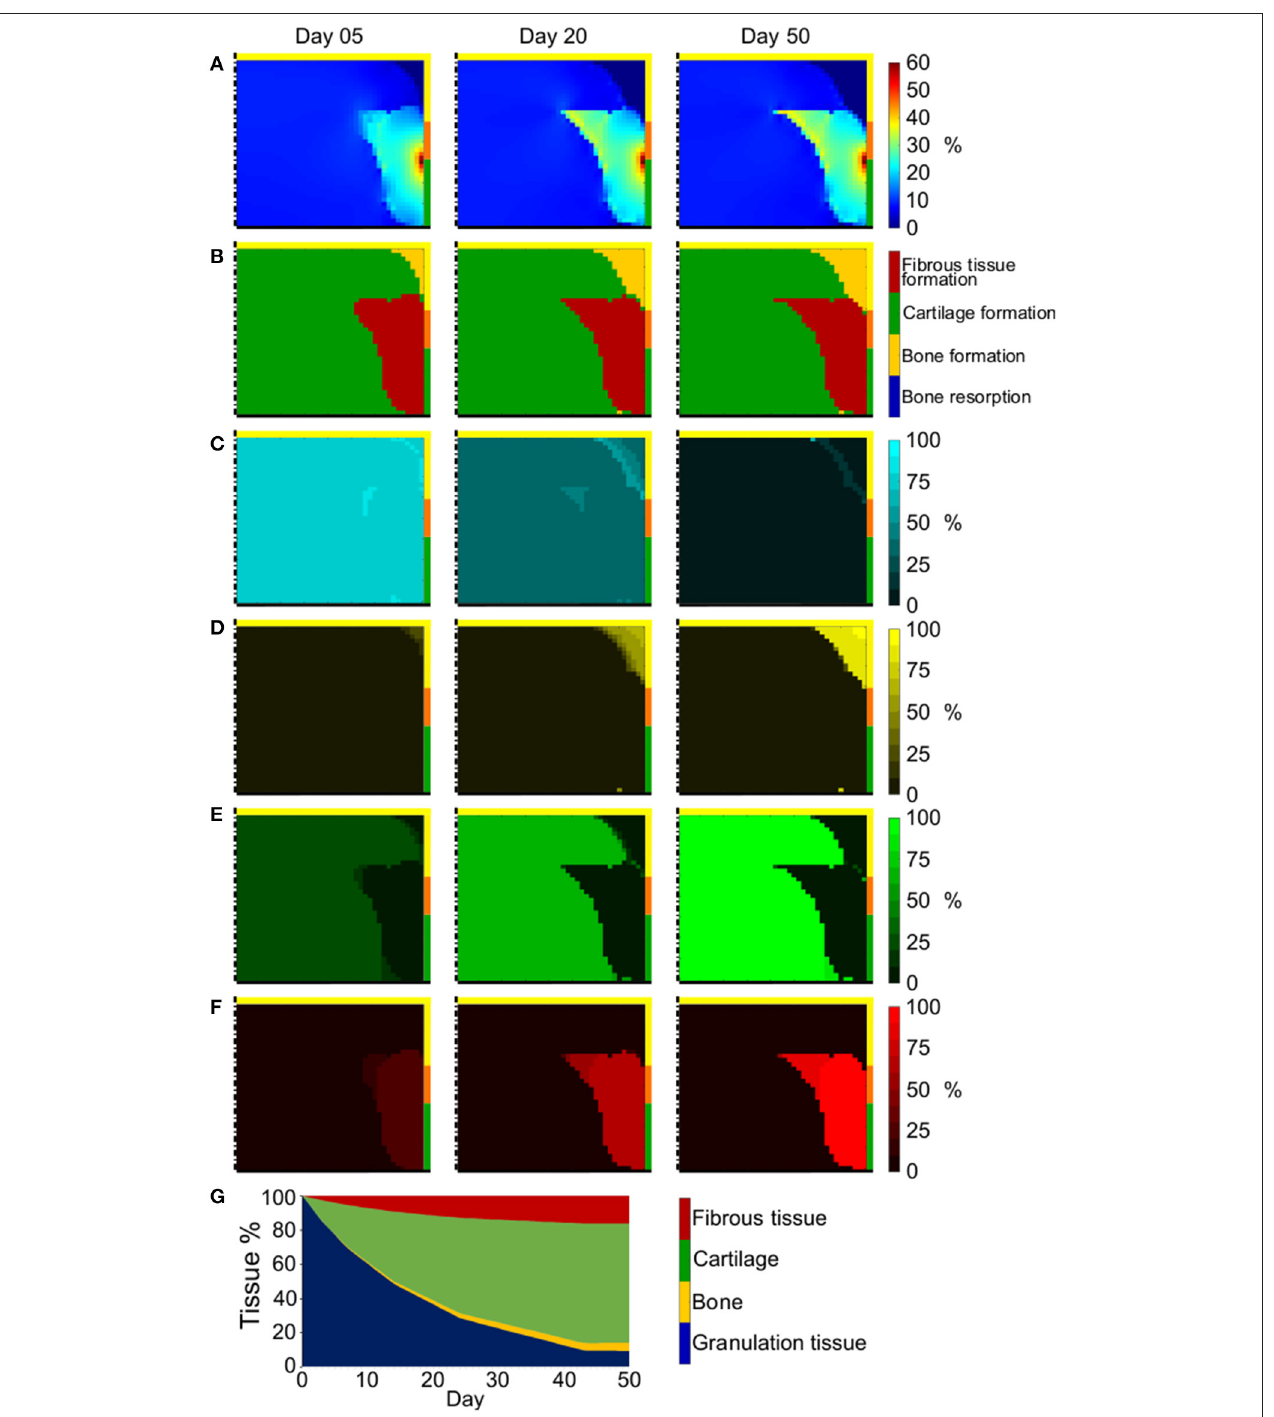
FIGURE 5 | Repair outcome of empty osteochondral defect with uniformly distributed progenitor cells. (A) Distribution of γ ; (B) prediction of tissue formation based on S; (C–F) amount and distribution of MSCs, osteoblasts, chondrocytes, and fibroblasts, respectively. Left, middle, and right columns show results at day 5, 20, and 50, respectively. The scale bars to interpret the plots are on the left side of the corresponding rows. The black dash-dot lines and the black solid lines mark the axis of symmetry and the articular interface, respectively. The colors of the borders indicate the neighboring tissues in the FE model of the femoral condyle: yellow, orange, and green stand for cancellous bone, subchondral bone, and cartilage, respectively; (G) quantification of tissues formed in the defect during the healing process.